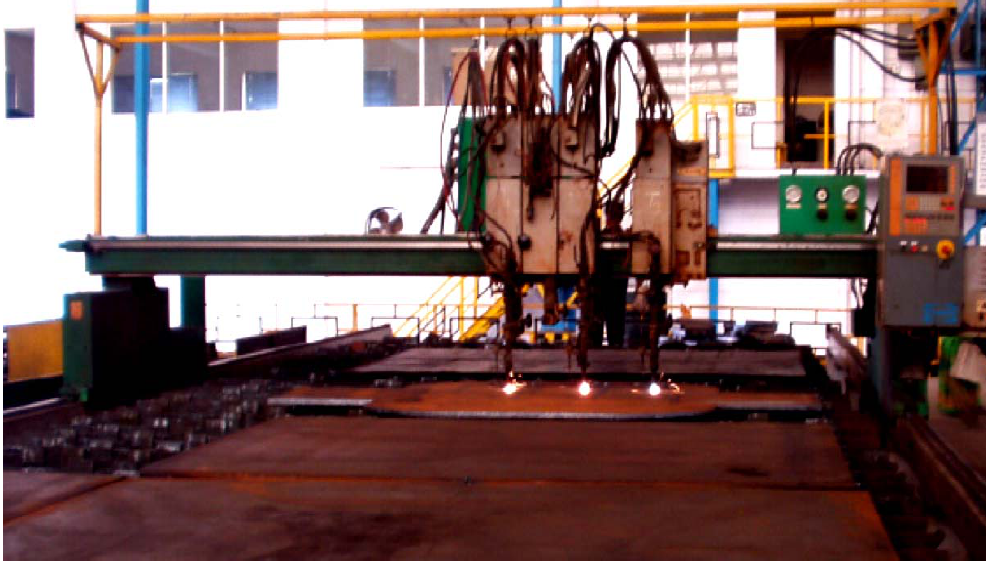
Figure 1. “Sample machine taken for root cause